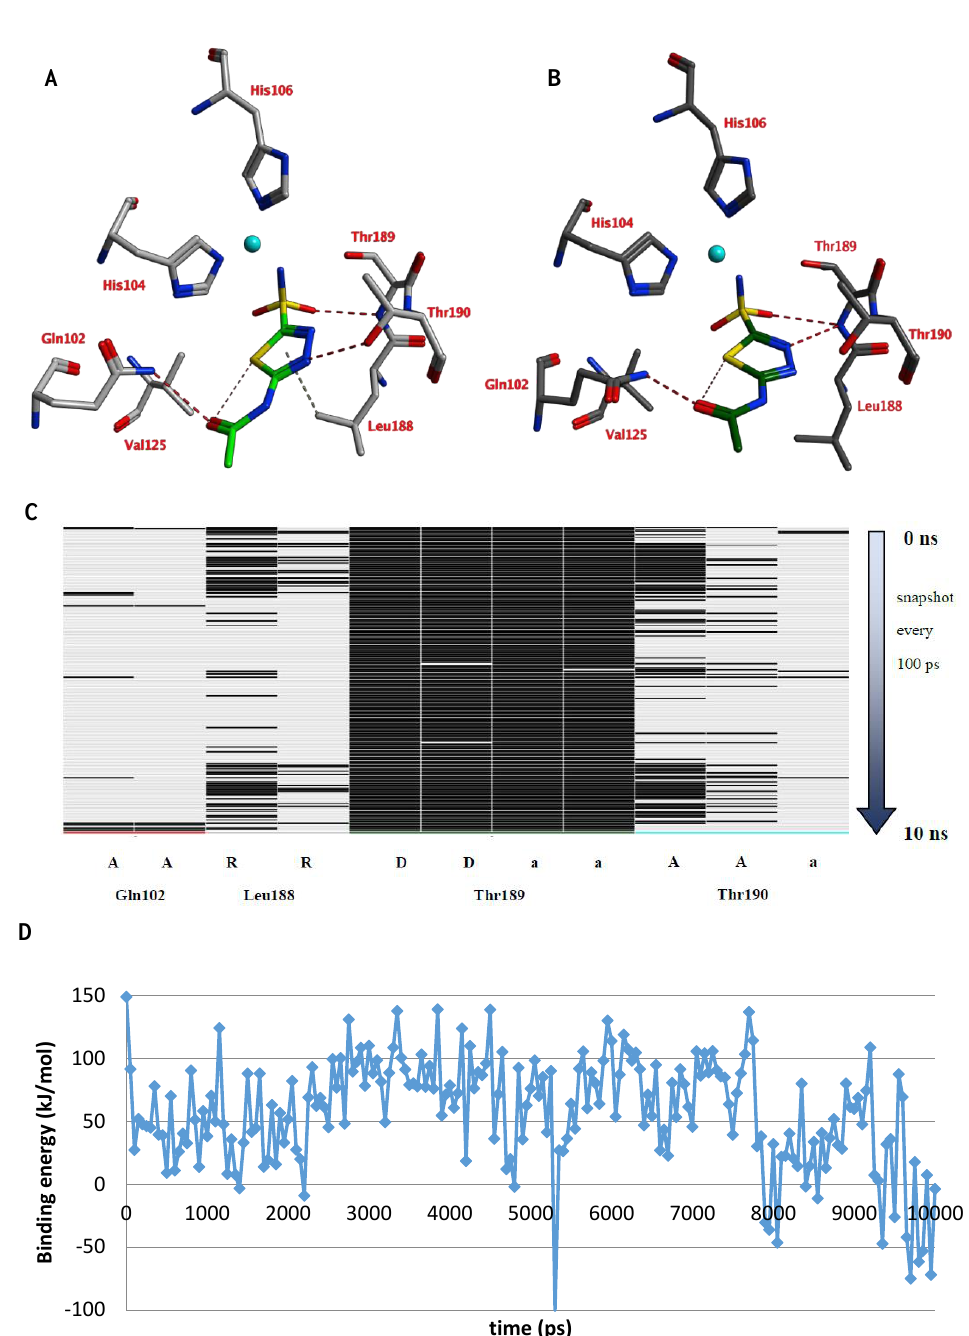
Figure 3. ( A ) The VcCA-azm model (t = 0 ns). ( B ) The VcCA-azm model after a 10 ns MD simulation. ( C ) The protein–ligand interaction fingerprint (PLIF) showing the interaction of azm with the VcCA binding pocket residues during the simulation as barcodes (a black line indicating the presence of the interaction at snapshot). ( D ) The binding energy (kJ / mol) between azm and VcCA. Hydrogen bonds are indicated in red dashed lines. H–arene interactions are indicated in yellow dashed lines. “A” indicates sidechain acceptor interactions, “a” indicates backbone acceptor interactions, “D” indicates side chain donor interactions, and “R” indicates H–arene interactions. Two interactions of the same type per residue (for example “A” for Gln102) indicates that multiple interactions of the specified type between ligand and residue are formed. The arrow indicates the sequence of snapshots of every 100 ps from 0 to 10 ns.